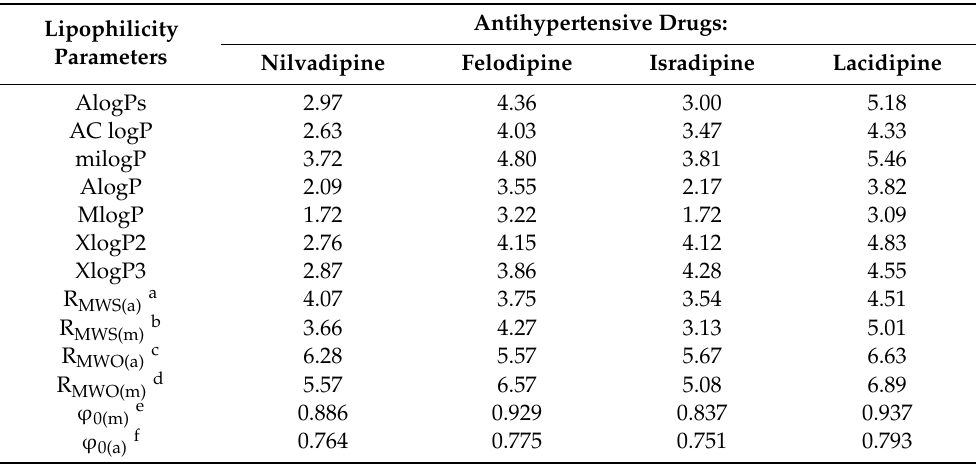
Table 2. Summary of the lipophilicity study of antihypertensive drugs by using the theoretical and RP-TLC methods.